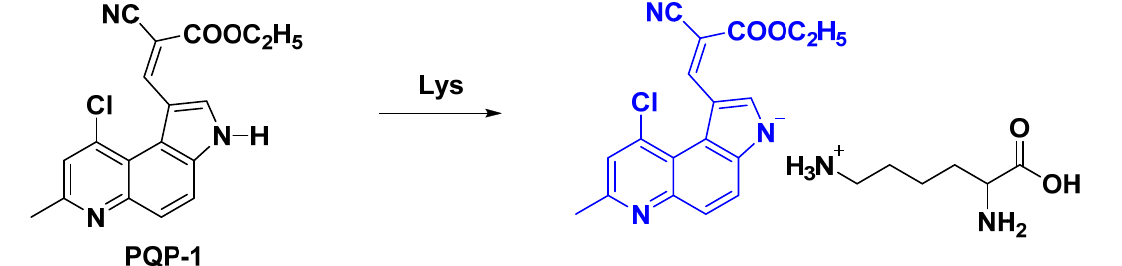
Figure 4. Proposed response mechanism between PQP ‐ 1 and lysine.